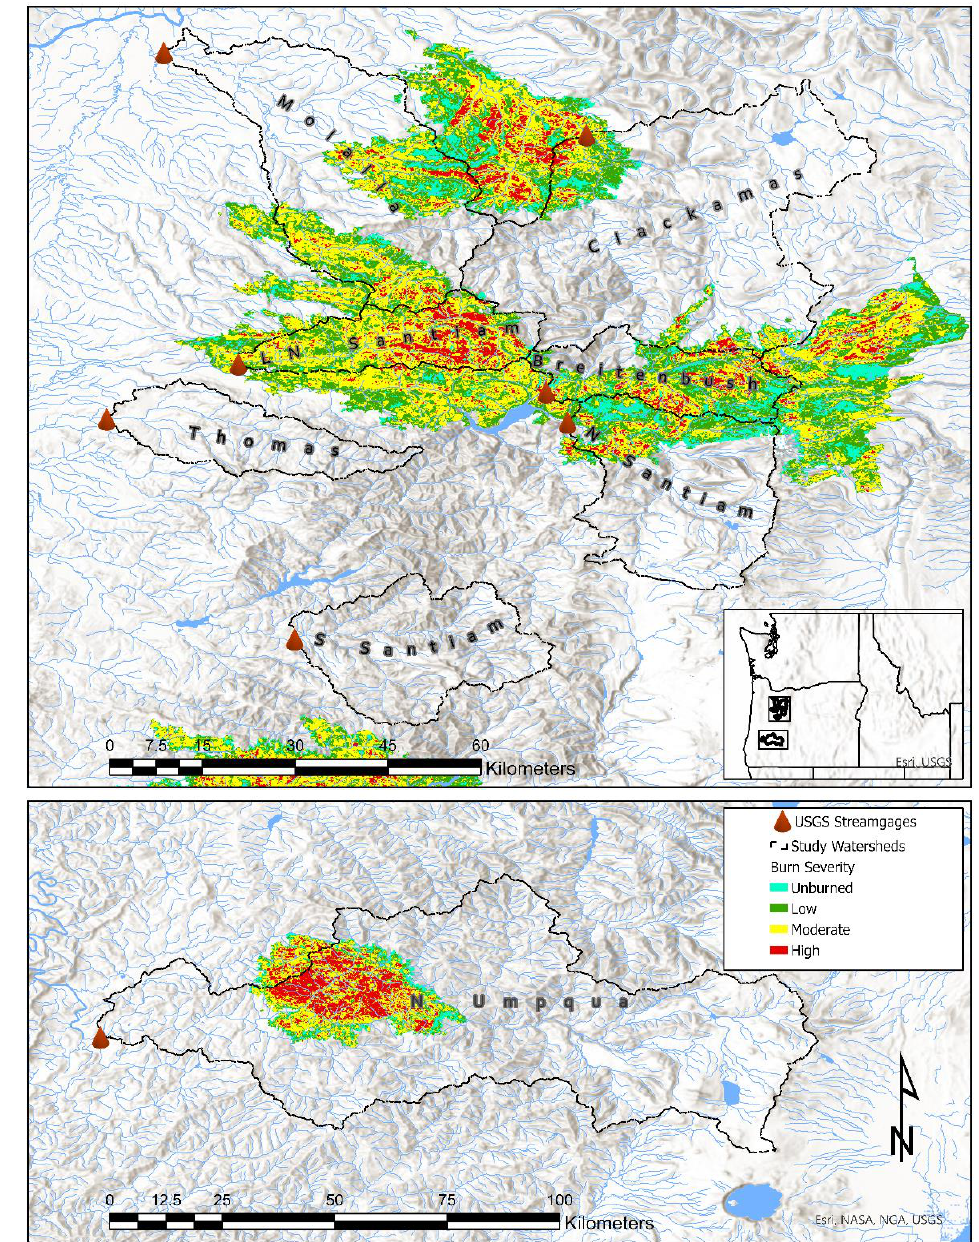
Figure 3. Oregon study area including the location USGS streamgaging stations, watershed bound- aries, and burn severity classes. Low burn severity includes areas where surface organics have not been completely combusted, roots are intact, and some patches of grey ash are present. Moderate burn severity includes areas where some surface organics and roots have been consumed, some needles and leaves may remain, and patches of grey/black ash are present. High burn severity includes areas where almost all the organic groundcover has been destroyed, many surface roots are consumed, bare soil is exposed and soil structure has been disturbed, stumps and trees are completely burned out in places, and thick deposits of white and grey ash are present [54].